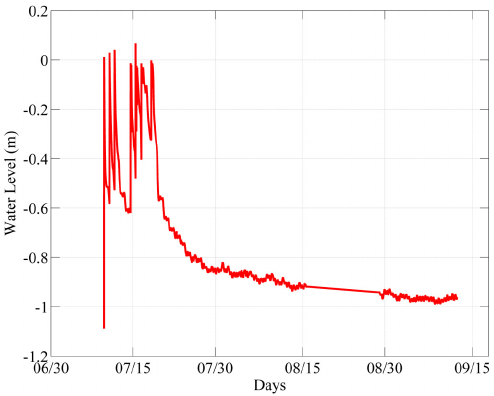
Figure 5. Water level fluctuations monitored with a time step of 15 min.